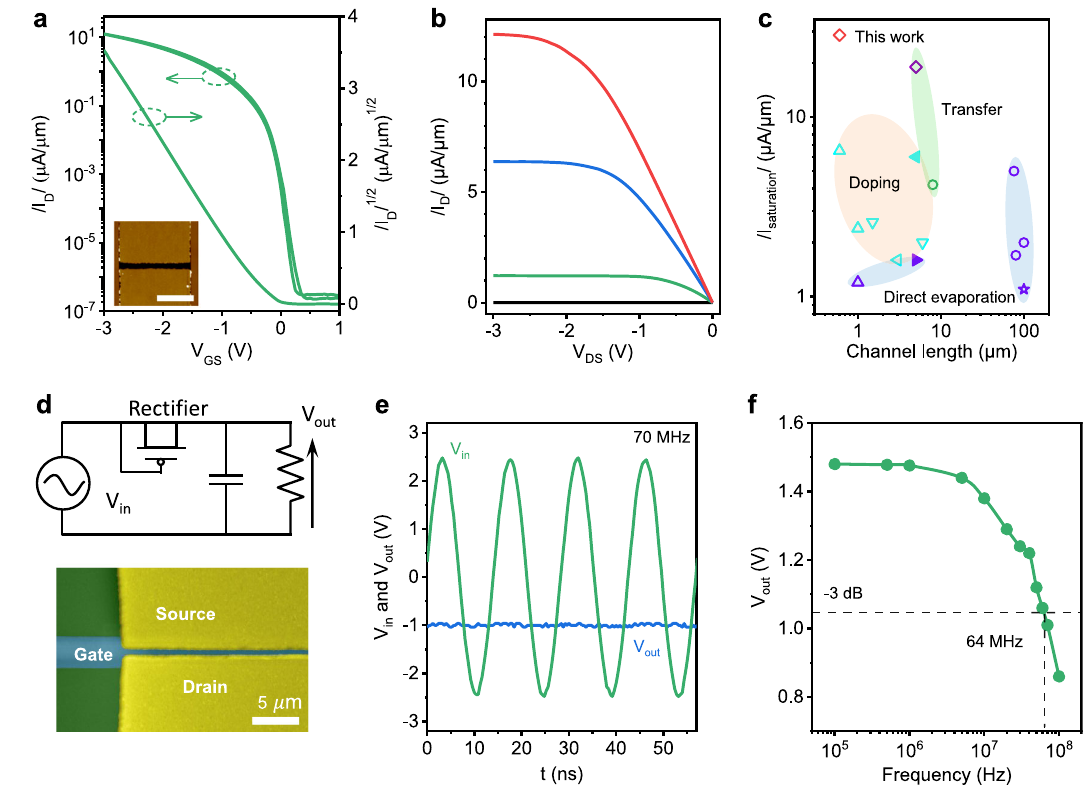
Fig. 4 | Ultrahigh performance of transferred-Pt OTFTs. a I D ~ V GS characteristics of typical transferred-Pt monolayer C 10 -DNTT OFET with channel length/width of 0.65/10 μ munder V DS = − 3.0V.InsetshowstheAFMimageof thedevice.Scalebar: 5 μ m. b I D ~ V DS characteristics of the device in a . From top to bottom, V GS = − 3.0V, − 2.0V, − 1.0V,and 0V, respectively. c The on-state saturation current asafunction of channel length for various OFETs made by the state-of-the-art contact technol- ogy. The symbols in c represent C 6 -DNTT (open circle), Ph-BTBT-C 10 (open star), C 8 -DNBDT-NW (open left triangle), C 9 -DNBDT-NW (open down triangle), Dph-